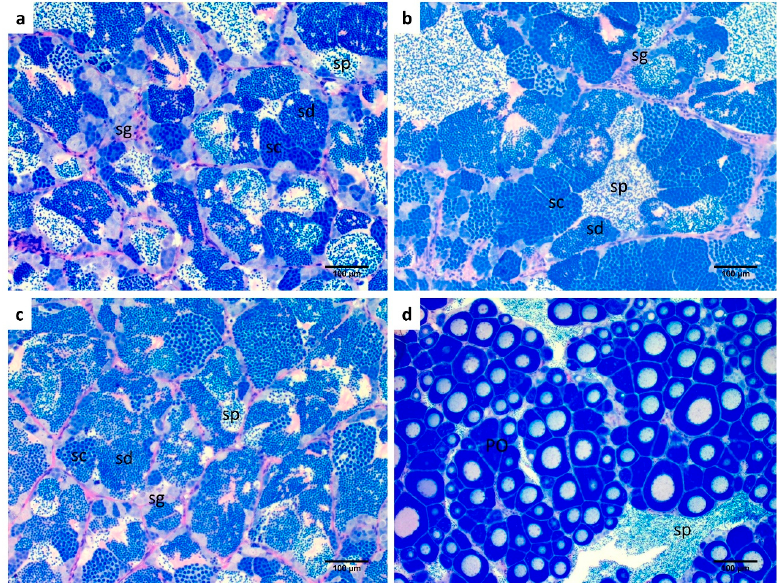
Figure 3. Histological images of gilthead sea bream gonads. Testicular tissue from ( a ) POST-CTRL ( b ) BPA LOW; ( c ) BPA HIGH and ( d ) ovotestis containing an ovarian part with primary oocytes (PO). Testicular part with spermatozoa (sp); sd: spermatids, sg: spermatogonia, sc: spermatocytes. Scale bar: 100 µm.